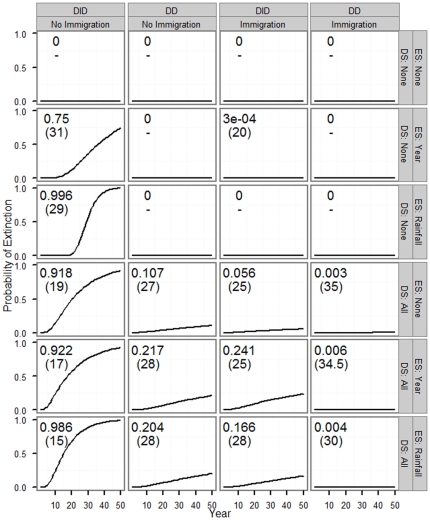
Probability of extinction by simulation scenario.The cumulative probability of extinction during a 50-yr period (i.e., probability that the population falls below one female) across 24 simulation scenarios depending on whether and how density dependence, immigration, demographic stochasticity, and environmental stochasticity were modeled. Scenarios are as follows: density-dependence - DID (density-independent vital rates) and DD (density-dependent survival); immigration - immigration ignored (No Immigration), and immigration included (Immigration); environmental stochasticity - environmental stochasticity ignored (ES: None), environmental stochasticity modeled with annual estimates of vital rates (ES: Year), and environmental stochasticity modeled with effects of average June–July rainfall on vital rates (ES: Rainfall); and demographic stochasticity - demographic stochasticity ignored (DS: None), and demographic stochasticity considered in all vital rates (DS: All). Cumulative probability of extinction for each scenario based on 10,000 simulations is represented by solid line. Probability of extinction within 50 years and median extinction time for each scenario are presented in large text within each figure panel. All scenarios started with 30 females, distributed to age classes according to stable age distribution for the overall population.